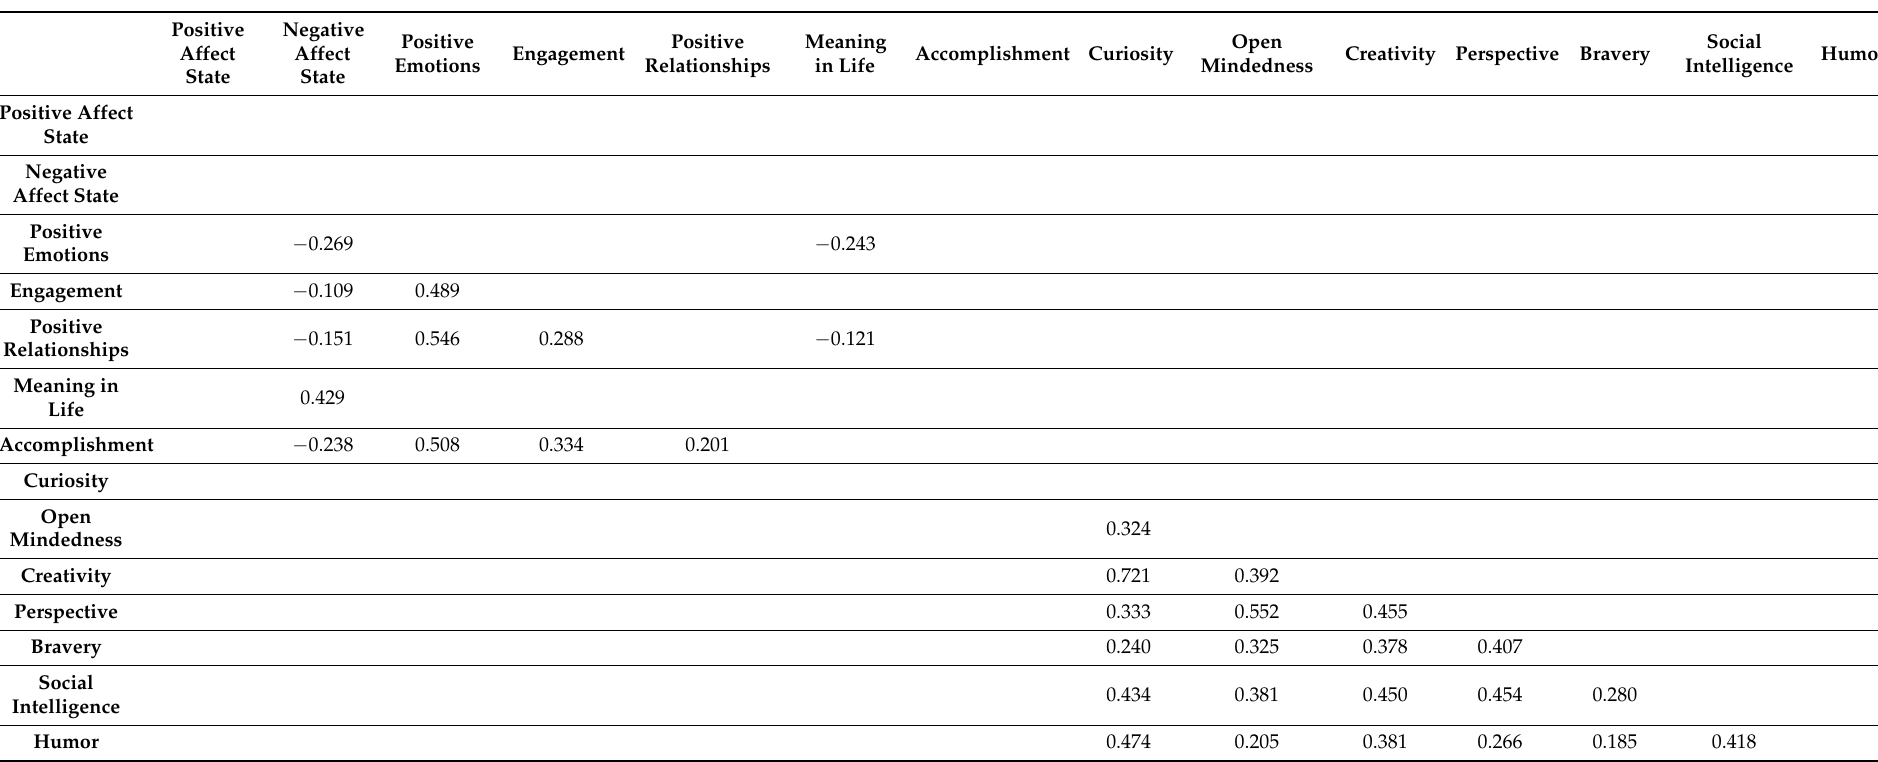
Table 3. Correlations between virtue of intellect dimensions and subjective wellbeing